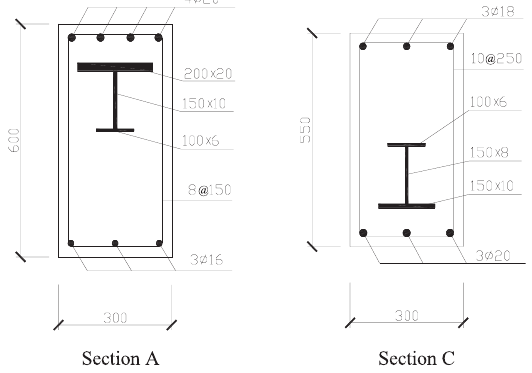
Fig. 6. Optimized section of SRC